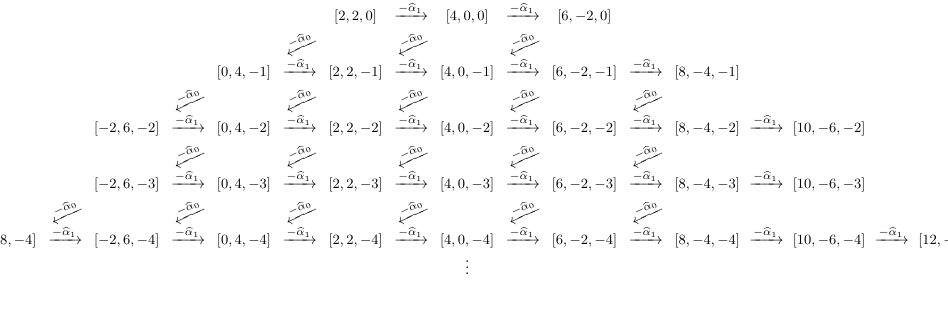
Table 7 . Representation with highest weight [2 ; 2 ; 0].